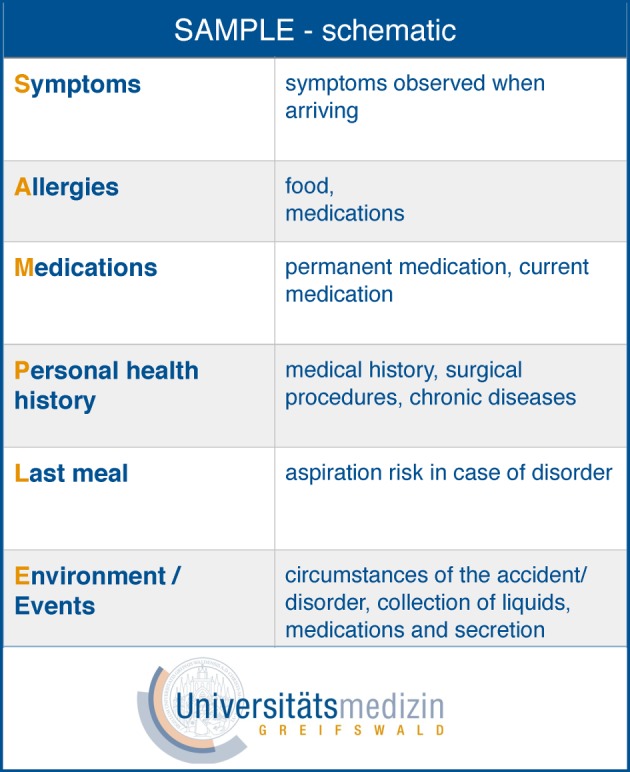
SAMPLE flashcard